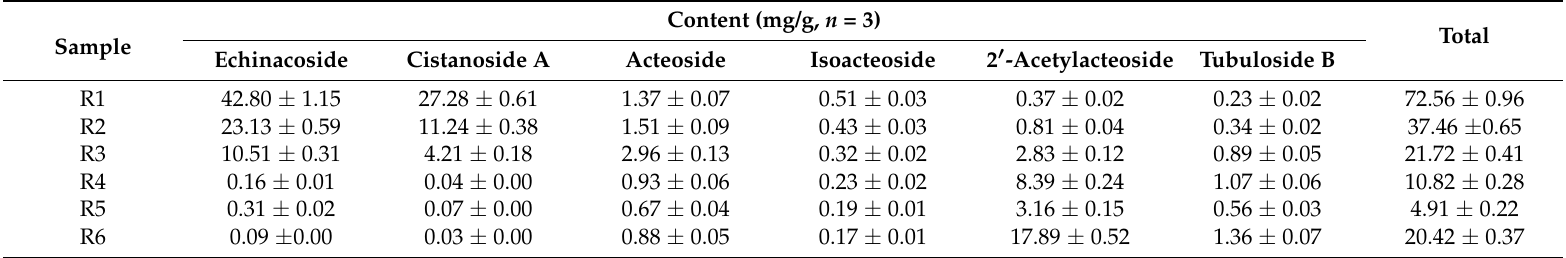
Table 4. The average contents of the six PhGs in the six different parts of Cistanche deserticola .